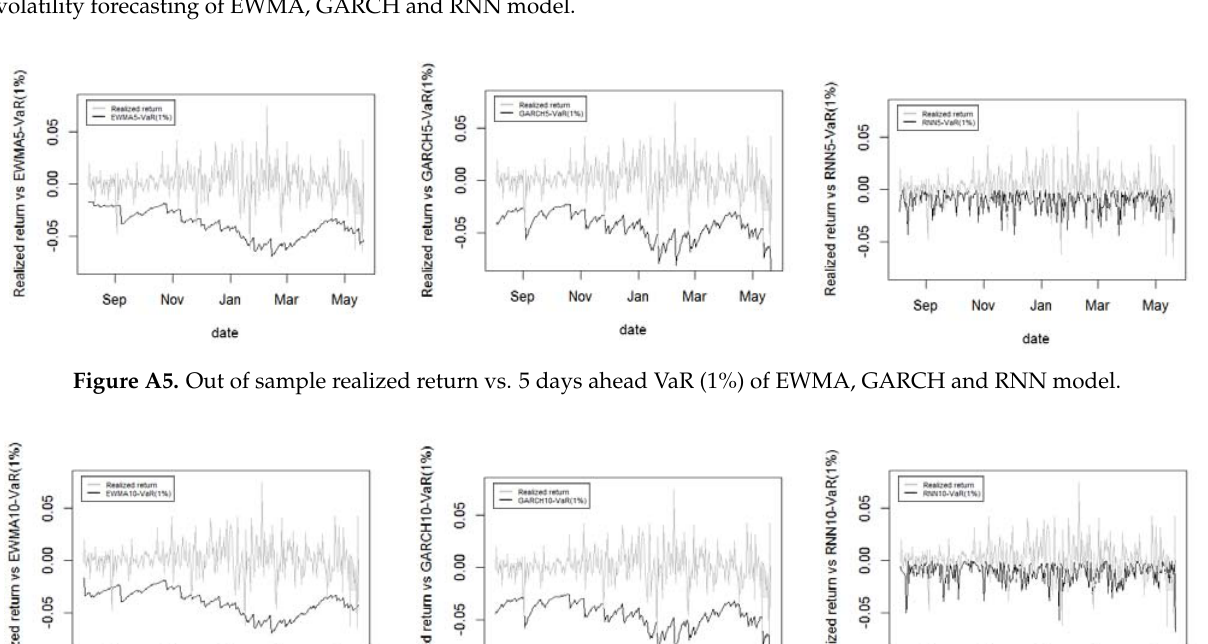
Figure A4. Out of sample standard deviation of realized volatility (2nd proxy) vs. standard deviation of 10 days ahead volatility forecasting of EWMA, GARCH and RNN model